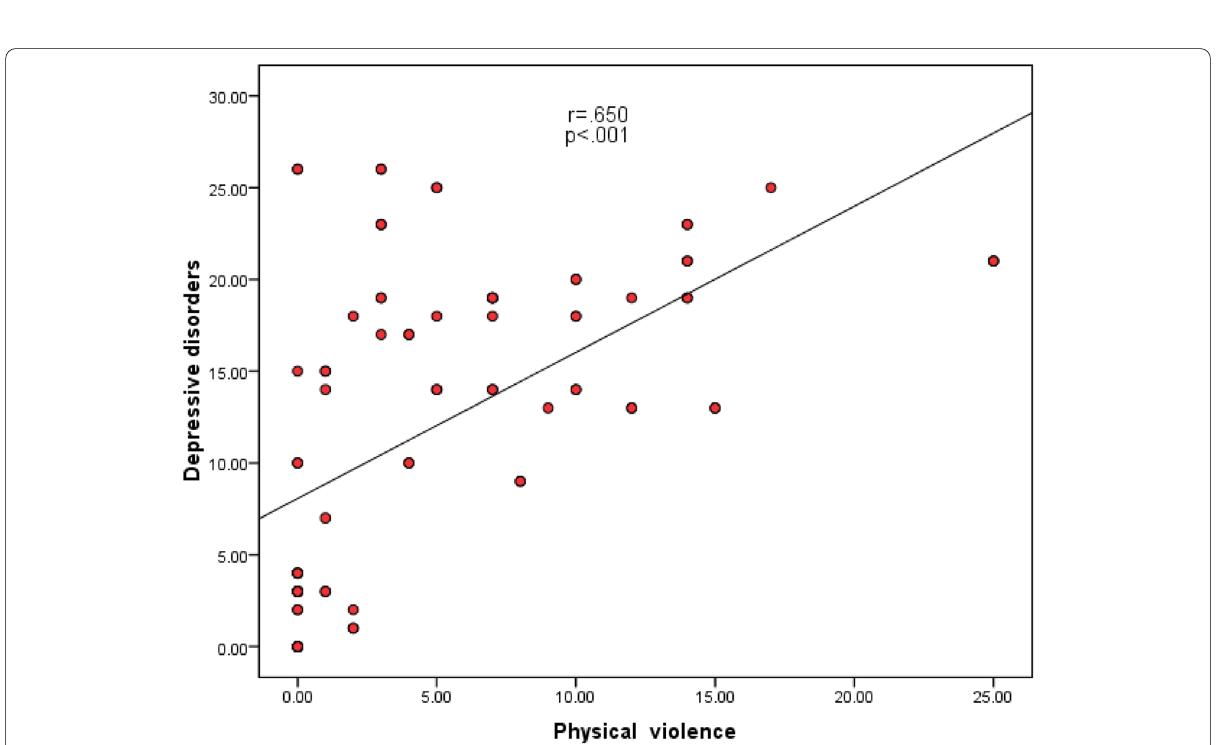
Fig. 6 Scatter diagram showing correlation between physical violence and depressive